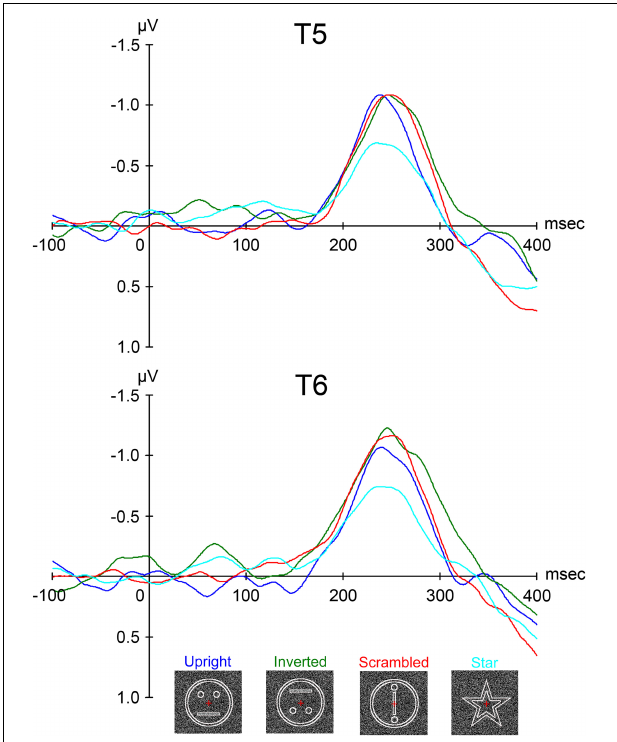
FIGURE 8 | The grand-averaged waveforms from all ten subjects of ERP for upright (schematic face), inverted (the upright stimulus inverted), scrambled (the same contours and features as in upright but with the spatial relation distorted), and star (a star shape whose occurrence was enumerated and then reported after sessions by the subjects) conditions at the T5 and T6 electrodes in the left and right temporal areas, respectively [adopted from Miki et al. (2009)]. ERP, event-related